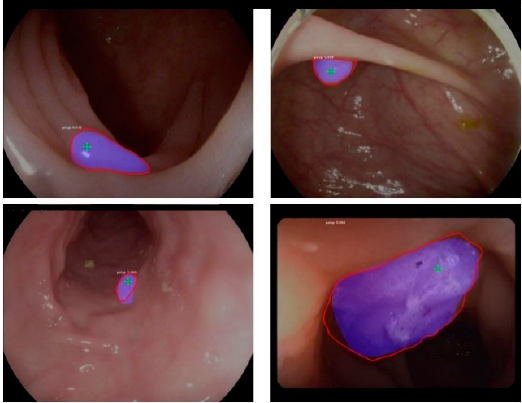
Figure 5. Polyp segmentation in colonoscopy images (ETIS-Larib). Blue overlay is the predicted segmentation mask. The contour of the ground truth masks is shown in red. Detection points are masked in green.